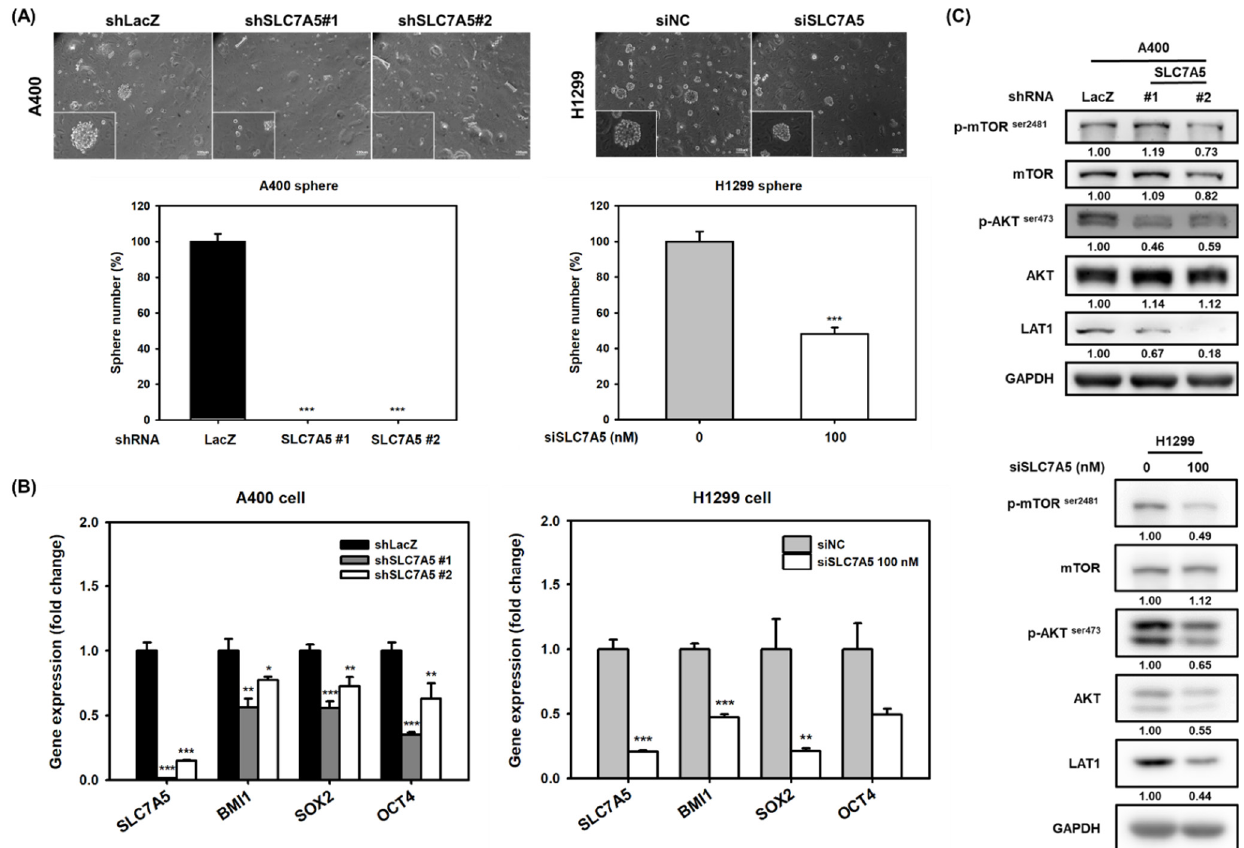
Figure 2. Knockdown of LAT1 reduces CSC activity and Akt/mTOR activation in NSCLC cells. ( A ) The knockdown of LAT1 in A400 and H1299 cells was performed by lentiviral delivery of LAT1-specific shRNAs (shSLC7A5#1 or shSLC7A5#2) and 100 nM of LAT1-specific siRNA oligonucleotides, respectively, for 48 h. The CSC activity was determined by tumorsphere cultivation. The inserted scale bars indicate 100 μ m in length. *** p < 0.001. ( B ) The mRNA expressions of cancer stemness genes (BMI1/SOX2/Oct4) and SLC7A5 were determined by real-time RT-PCR. * p < 0.05; ** p < 0.01; *** p < 0.001. ( C ) The protein expressions of phosphor-mTOR ser2481 , mTOR, phosphor-Akt ser473 , Akt, and LAT1 were determined by Western blot analysis. GAPDH was used as a protein-loading control. The inserted numbers present relative expression folds in comparison to shLacZ or the control siRNA group.